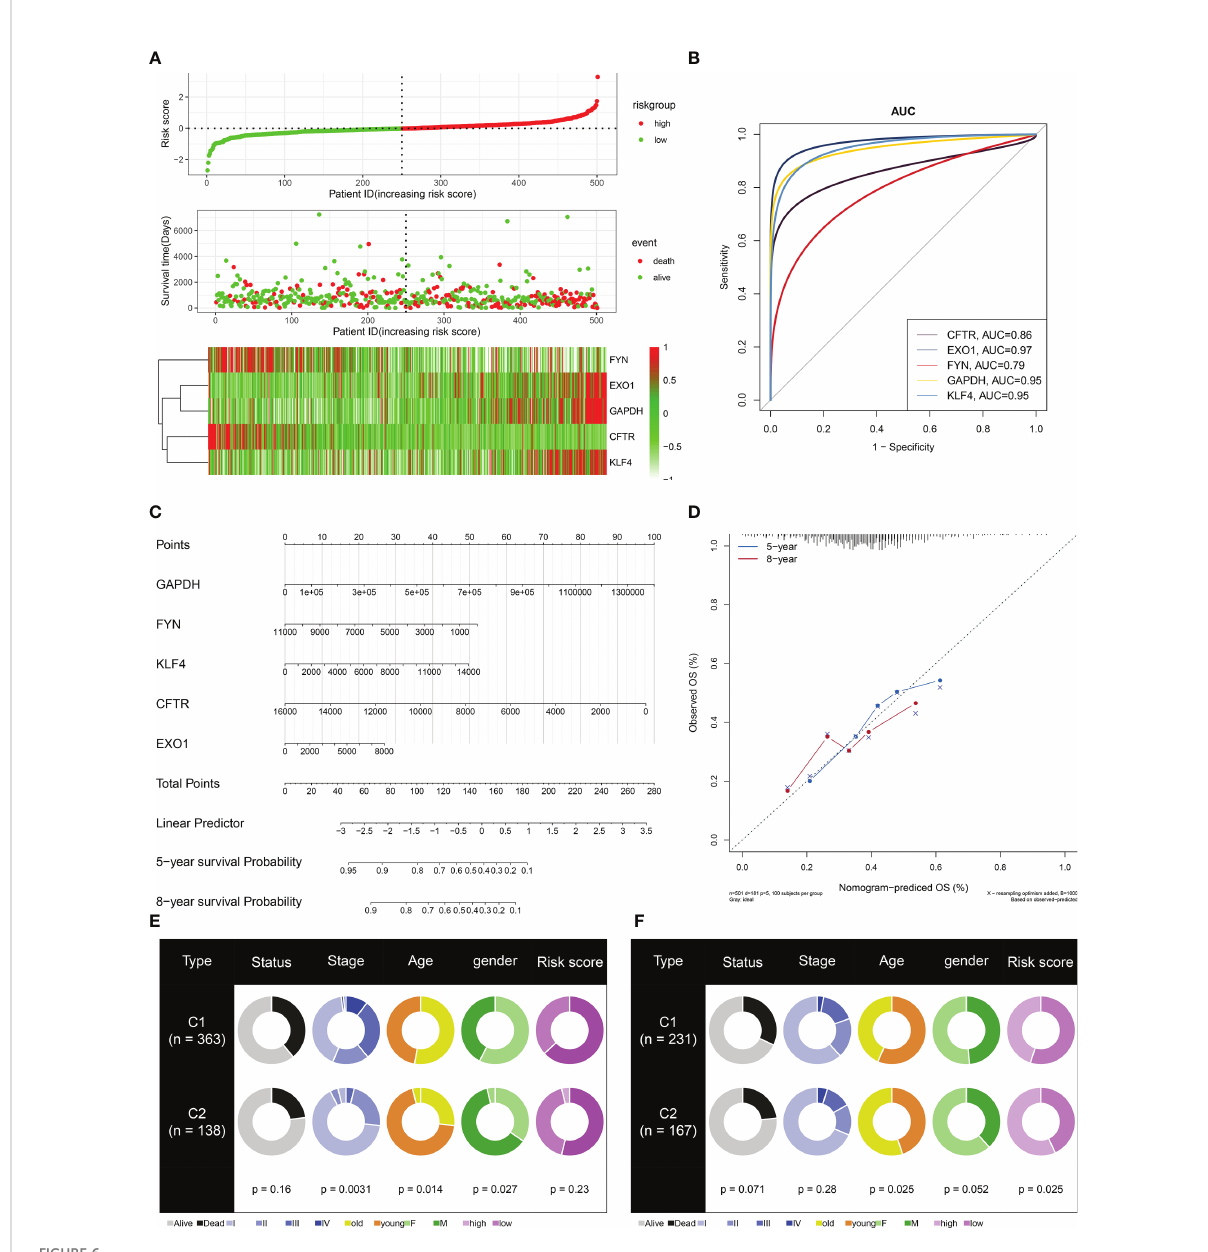
FIGURE 6 De fi nition of a scoring system based on key module genes for LUAD prognosis. (A) Distribution of risk score, survival state, and mRNA levels of key module genes. (B) ROCs for evaluation of the prediction capacity of each key module gene in LUAD prognosis. (C) The key module gene- based nomogram for inferring LUAD cases ’ OS time. (D) Agreement in 5-year and 8-year OS outcomes between the actual data and the nomogram estimation. (E, F) Comparison of clinicopathological features and risk score between C1 and C2 subtypes in TCGA-LUAD and GSE72094 datasets. LUAD, lung adenocarcinoma ROCs, receiver operating characteristics; OS, overall